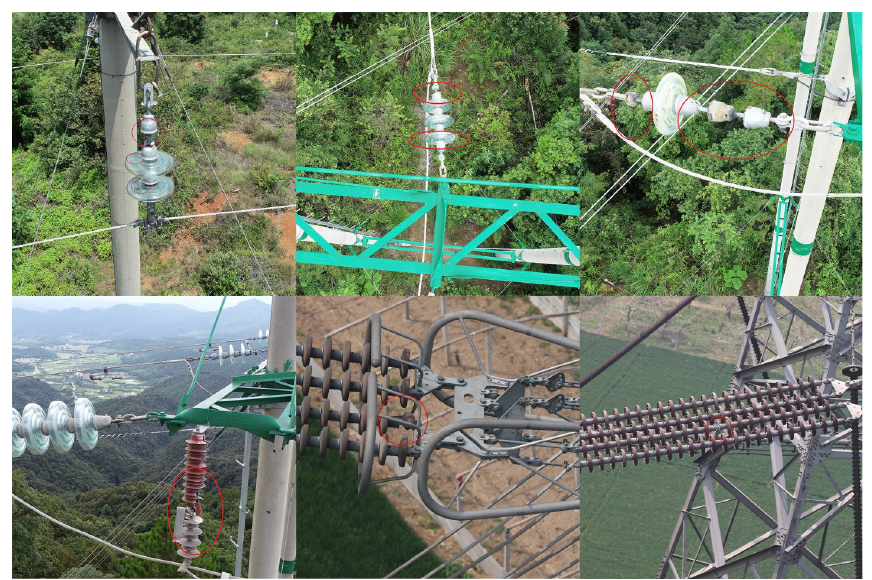
Fig 7. Partial image set of insulators.